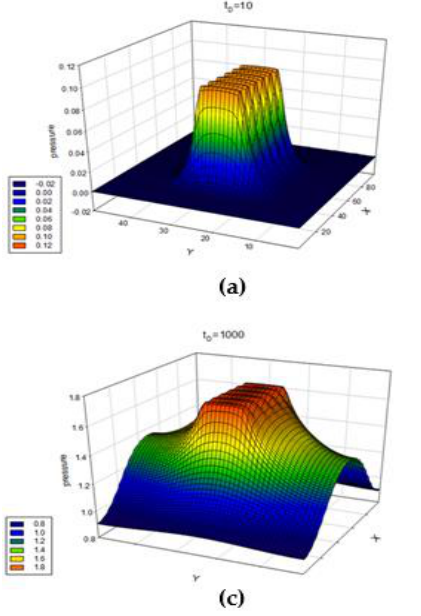
Figure 22. Rate response of fractured, horizontal well under a different ratio of local SRV width and space between fractures as k 1 / k 2 = 20, 2 L fD / Y eD = 0.1, X eD = 200, and Y eD = 100. Spatial pressure profiles within the reservoir for such a complex reservoir–well system at a different time t D = 10, 100 and 1000 are mapped out and illustrated in Figure 23 with L srvD / d fsD = 0.5. The high level of accuracy of the solutions is clearly demonstrated in these profiles.